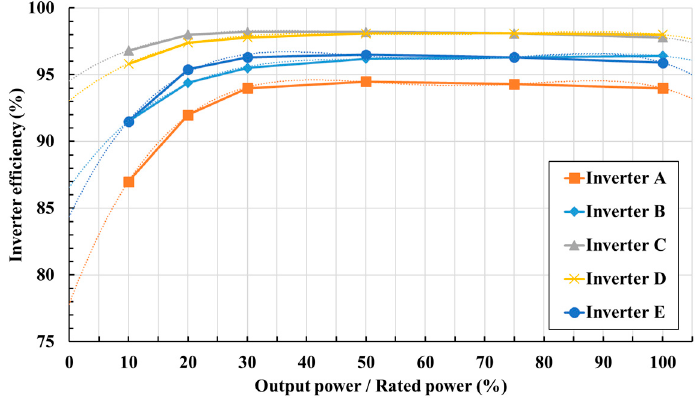
Figure 4. Example of inverter efficiency depending on the power level. 74